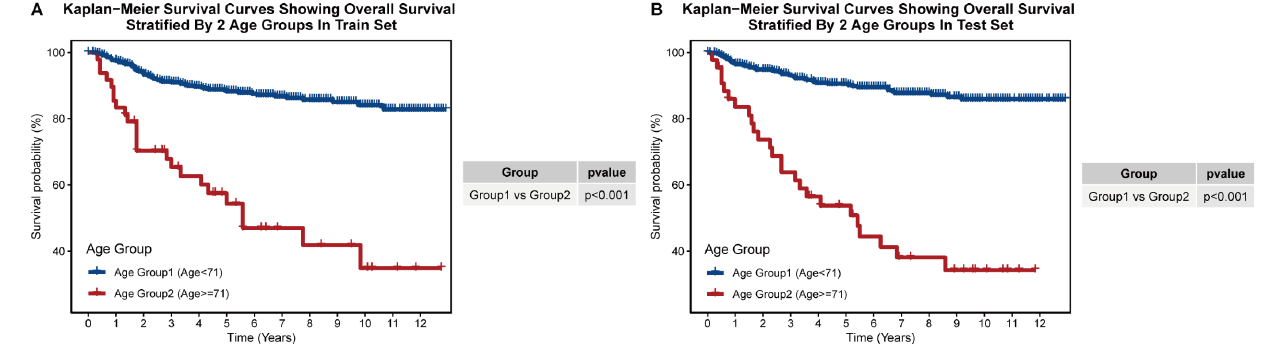
Figure 3. Construction of the age grouping system for MPTB. ( A ) Kaplan–Meier plot showing overall survival stratified by age group in training set. ( B ) Kaplan–Meier plot showing overall survival stratified by age group in the test